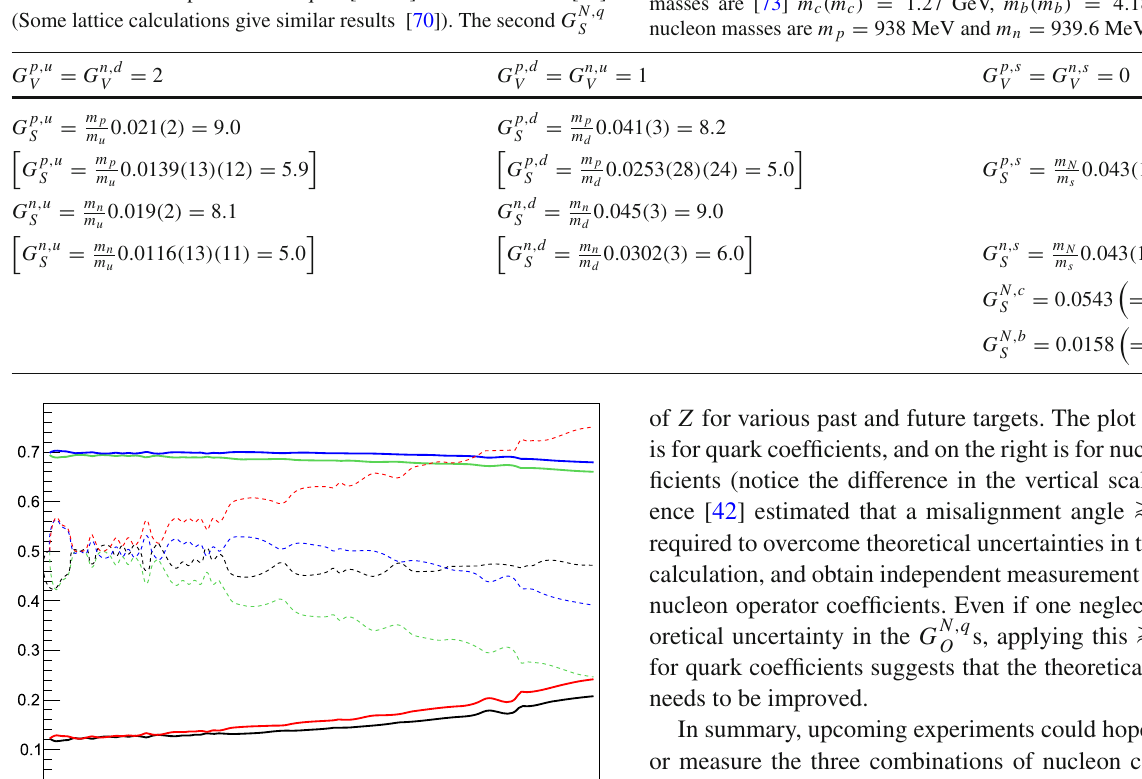
Table 4 Expectation values of vector and scalar quark currents in the nucleon; the scalar values are sometimes called f N q [63], and for light quarks are related to σ π N [64], where G N